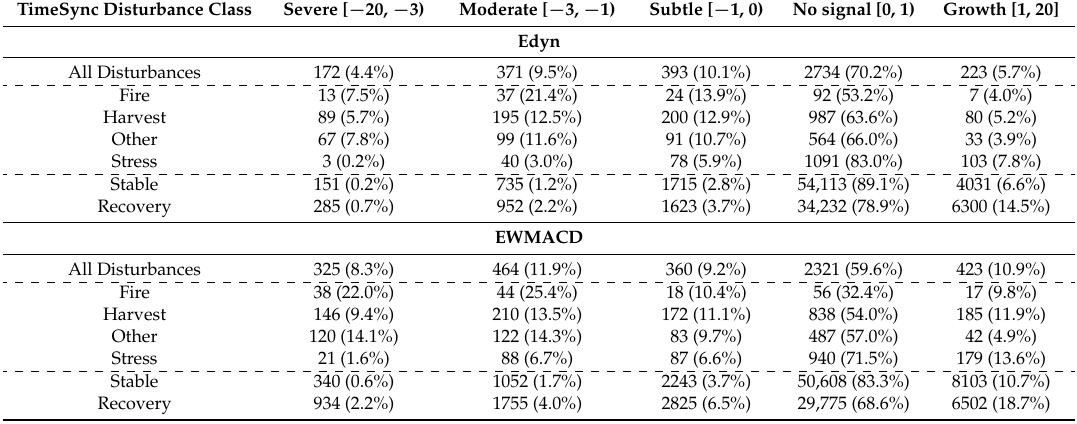
Table 3. Edyn/EWMACD signal magnitudes for forested pixels by TimeSync disturbance class, year-by-year. Note that an Edyn value of 0 can also indicate that it is retraining the reference curve. Percentages sum to 100% row-wise, within reference disturbance classes: for example, omission error rates may be derived for the disturbance classes by summing the No signal and Growth percentages within each row (except for Stable and